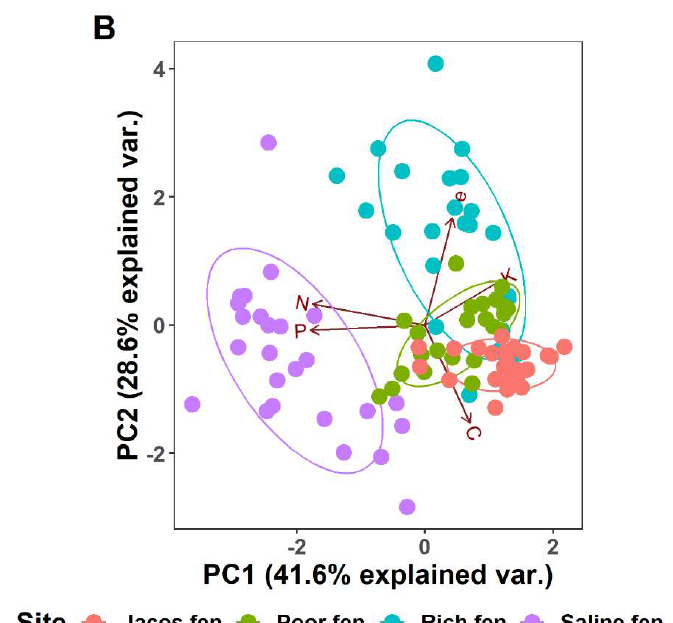
Figure 4. Principal components analysis of major element concentrations in ( A ) all living vegetation tissues across both plant functional types and ( B ) all peat material across both microforms across all four fen sites, shown with 68% probability ellipses for each